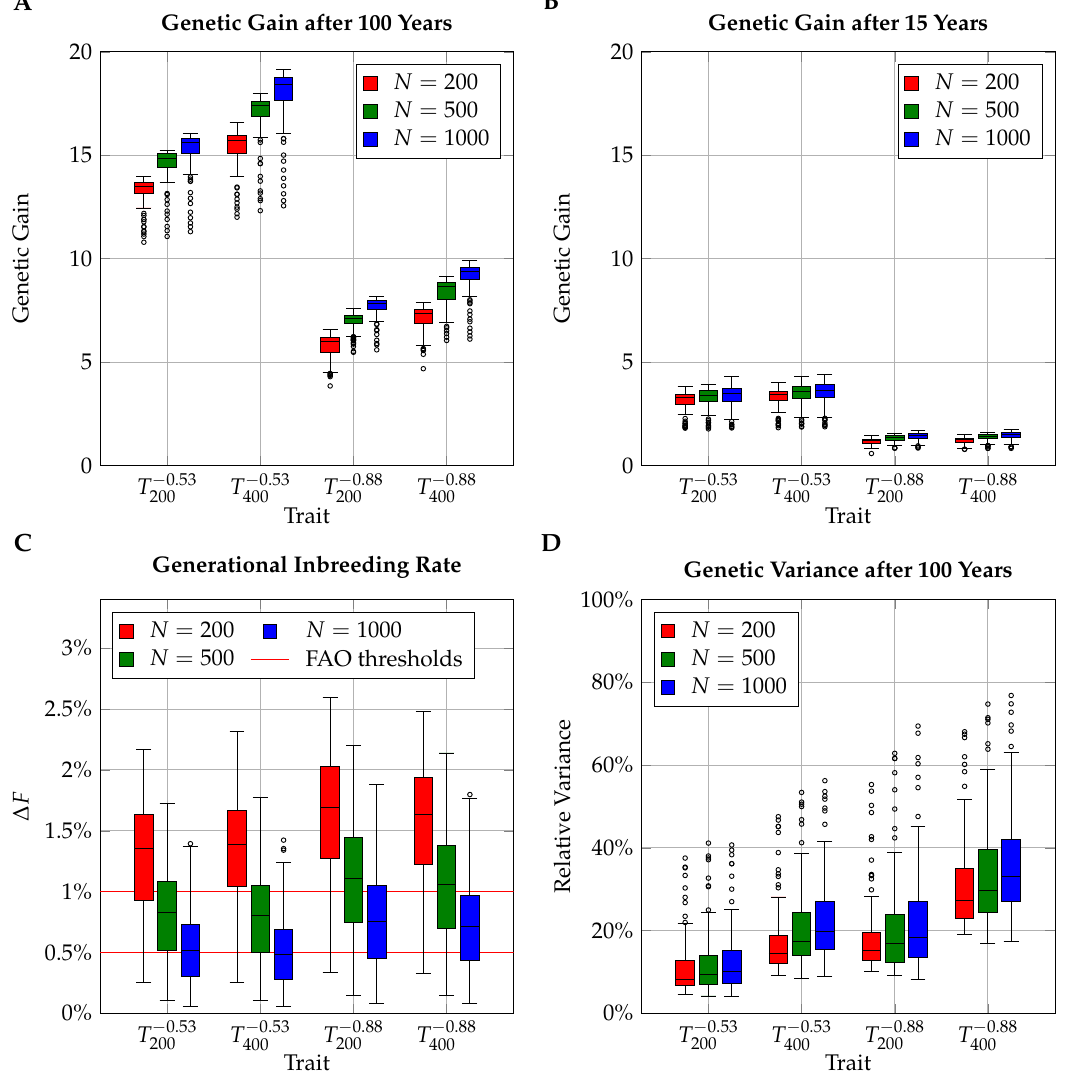
Figure 1. Simulated results for genetic gain after 100 ( A ) and after 15 years ( B ), generational inbreeding rates ( C ), and remaining genetic variance after 100 years ( D ). Individual boxplots are drawn for combinations of population sizes ( N = 200, N = 500, N = 1000) and selection traits ( T − 0.53 T − 0.88 , T − 0.88 ), signifying different numbers of influential loci ( N l = 200,400) and correlations between 200 400 maternal and direct effects ( r md = − 0.53, − 0.88). The boxplots comprise the results obtained for varying sister group sizes (1 ≤ k d ≤ 10) and selection rates for sires (1 ≤ k s ≤